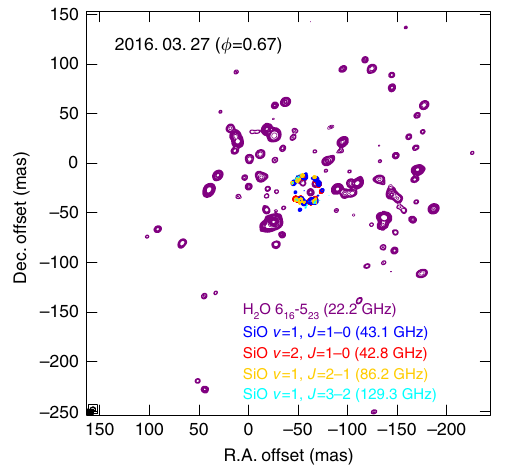
Fig. 1 Astrometrically registered velocity-integrated intensity maps of 22.2 GHz H 2 O and 43.1/42.8/86.2/129.3 GHz SiO masers obtained from the SFPR technique toward VX Sgr (in press manuscript 14 ). The rms noise levels on the maps are 115.4, 18.01, 15.45, 33.69, and 11.59 Jy beam − 1 m s − 1 , respectively, in order of the maser transition. The peak fl ux values are 573.62, 55.65, 38.08, 61.70, and 1.85 Jy beam − 1 km s – 1 . The contour levels are adopted at 10 12 15 20 25 30 50... for multiples of each rms